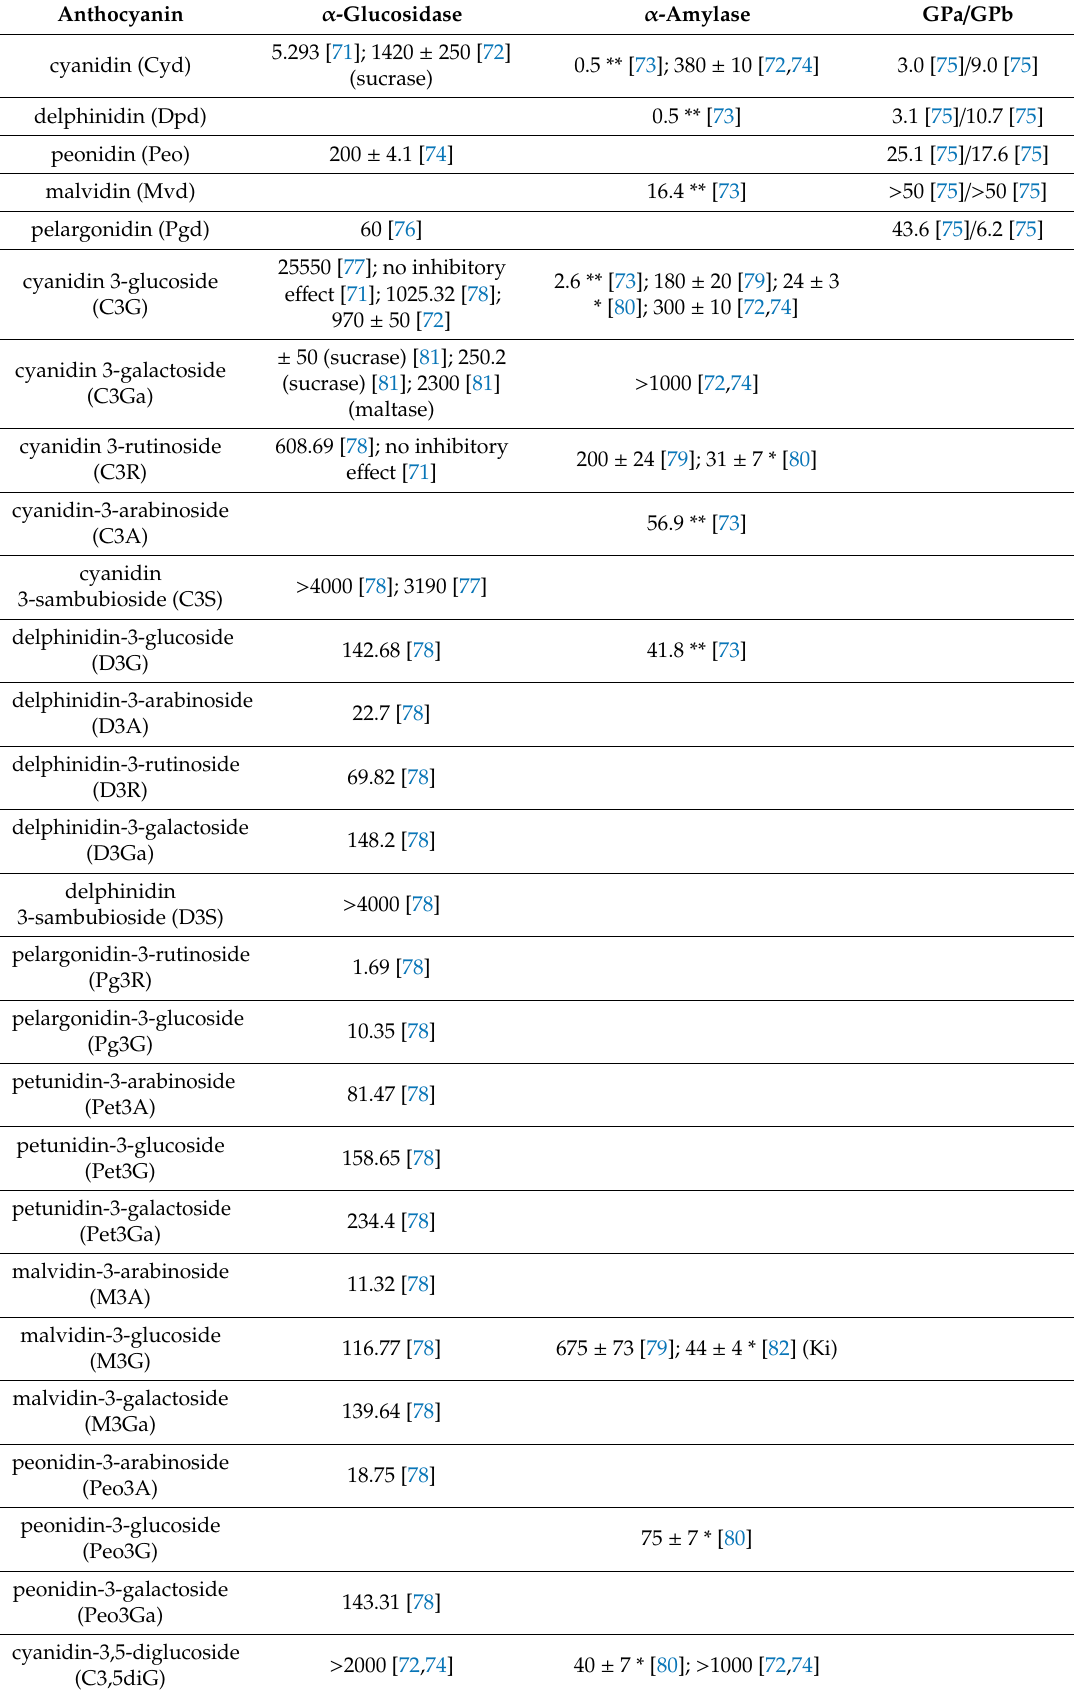
Table 1. IC 50 values (in µ M) for anthocyanins against the human α -glucosidase, α -amylase and glycogen phosphorylase (GPa and GPb forms) enzymes. *—values obtained in assays with porcine pancreatic α -amylase; **—values in µ g /